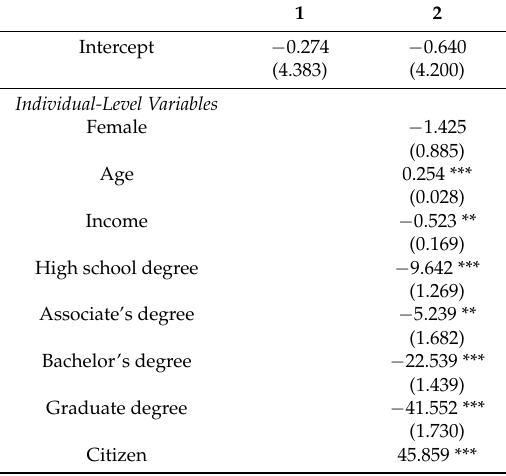
Table 4. Individual-level determinants of perceived immigrant threat. ( n = 18,433 individuals nested within 22 countries).